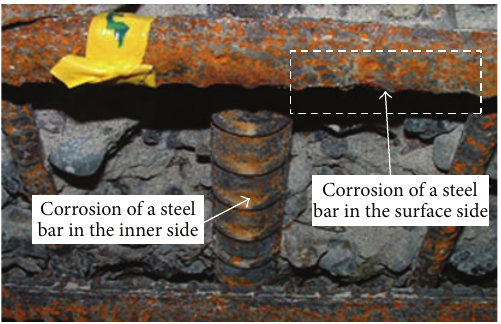
Figure 2: Actual situations of corrosion of steel bars in the vicinity of the under surface in a bridge